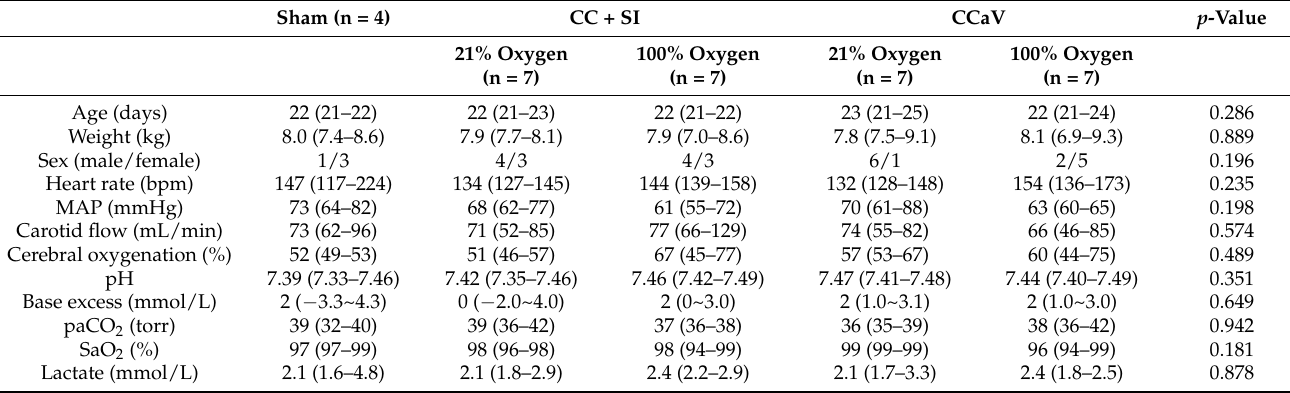
Table 1. Baseline